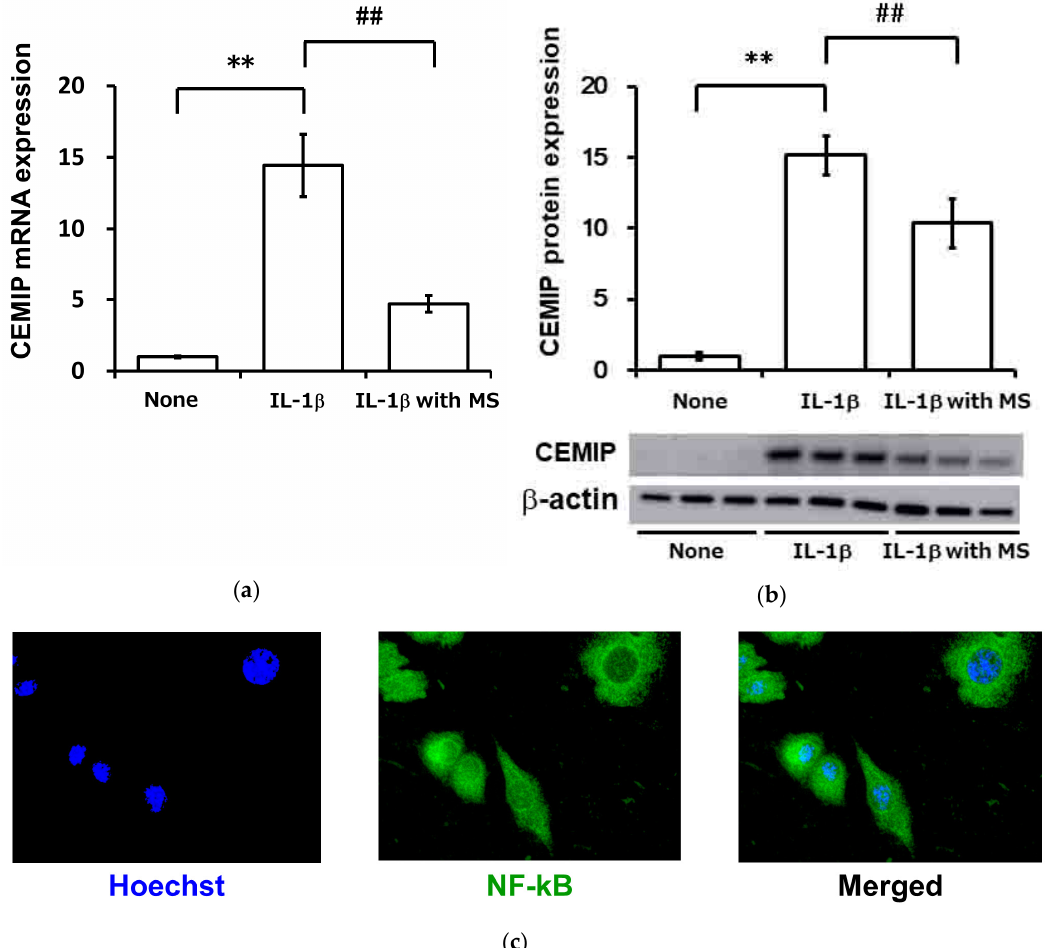
Figure 9. Mechanical strain attenuates IL-1 β -induced CEMIP expression by inhibiting NF- κ B (p65) translocation to the nucleus. OUMS-27 cells were treated with IL-1 β and mechanical strain (0.5 Hz, 5% elongation) for 12 h. ( a ) CEMIP mRNA expression was then measured by qRT-PCR. ( b ) CEMIP protein expression was detected by Western blotting. Values represent mean ± SD (a, mRNA, n = 6 per group; b, protein, n = 3 per group). ** p < 0.01 vs. control. ## p < 0.01 vs. IL-1 β -stimulated group with mechanical strain. ( c ) OUMS-27 cells were seeded on a collagen-coated stretch chamber. After 24 h serum starvation, the cells were treated with IL-1 β for 10 min with or without MS (0.5 Hz, 5% elongation). NF- κ B p65 (green) was detected by immunocytochemistry and nuclei were stained with Hoechst 33258 (blue).